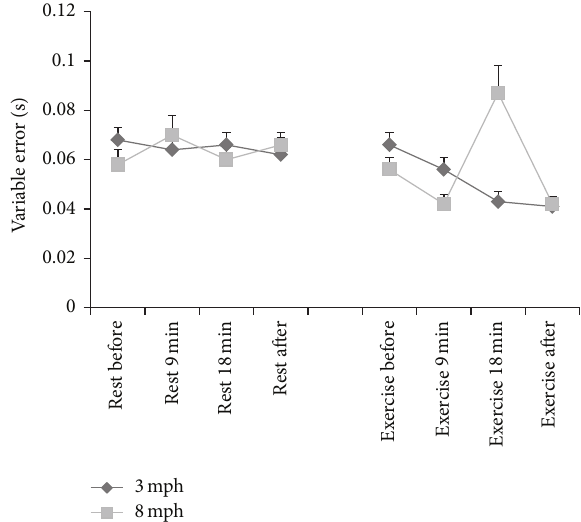
Figure 3: Mean ± SE of variable error (secs) in rest and exercise conditions,atstimulusspeedsof3and8 mphandinrestandexercise conditions.